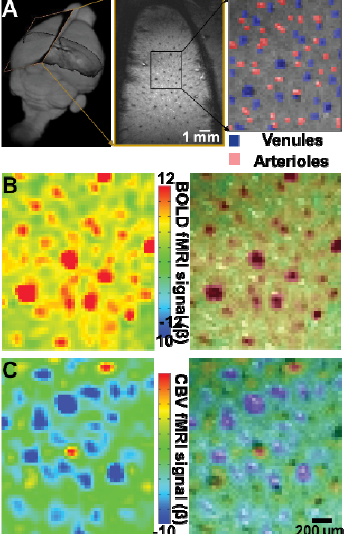
Figure 1. Vessel-specific BOLD and CBV signals with single-vessel fMRI. ( A ). 2D multigradient-echo (MGE) slice is acquired across the deep-layer cortex to identify penetrating arterioles (red) and venules (blue). ( B ). The evoked BOLD fMRI signal of the forepaw somatosensory cortex (FP-S1) is located at the penetrating venules. ( C ). The evoked CBV fMRI signal of FP-S1 is located at the penetrating arterioles. Adapted from Yu et al. 2016.